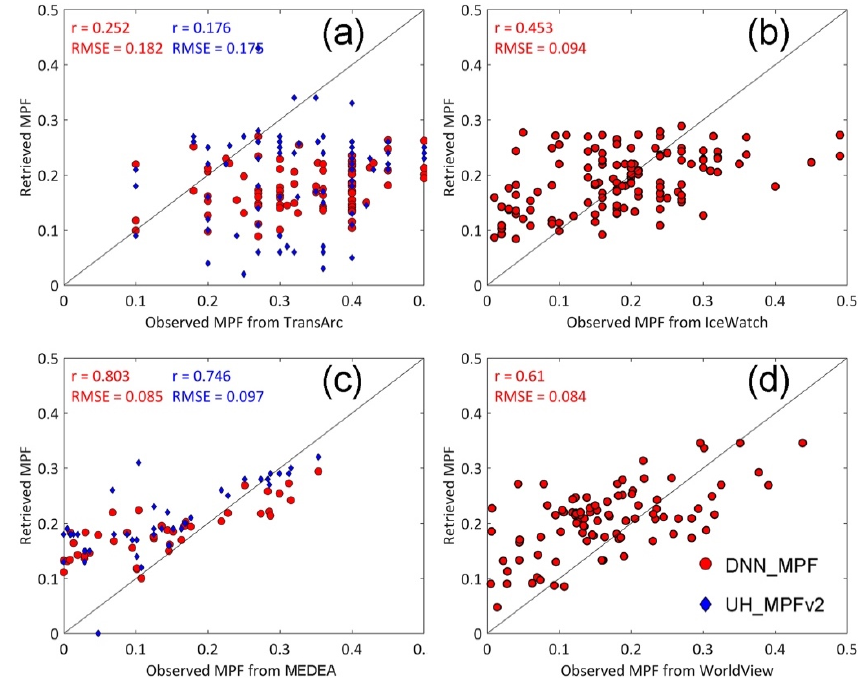
Figure 8. Independent validation of the DNN_MPF and UH_MPFv2 against the observed MPF on the 12.5 km polar stereographic grid. ( a ) TransArc, ( b ) IceWatch, ( c ) MEDEA, ( d ) WorldView.